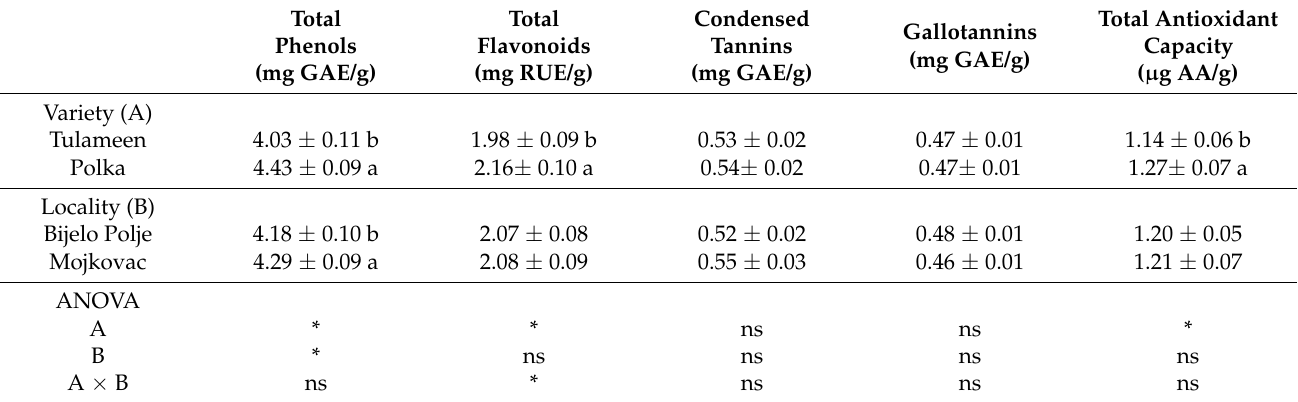
Table 3. Secondary chemical compounds content in raspberry